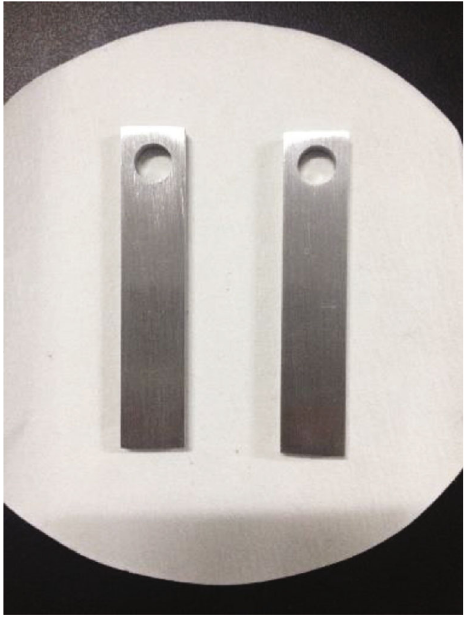
Figure 1: Steel coupons for